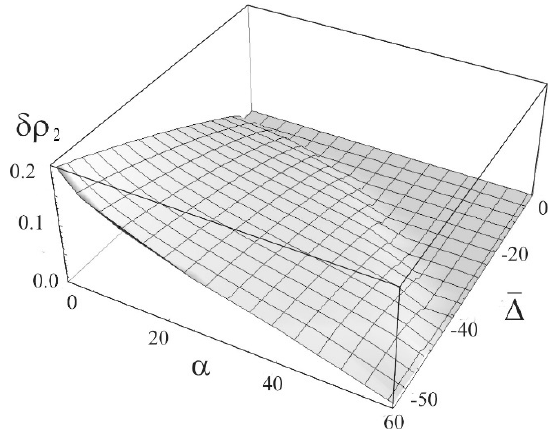
Figure 3. Dependence of the width of the bistability region of the population of the second level on the coefficient of exciton-exciton annihilation α and detuning Δ .